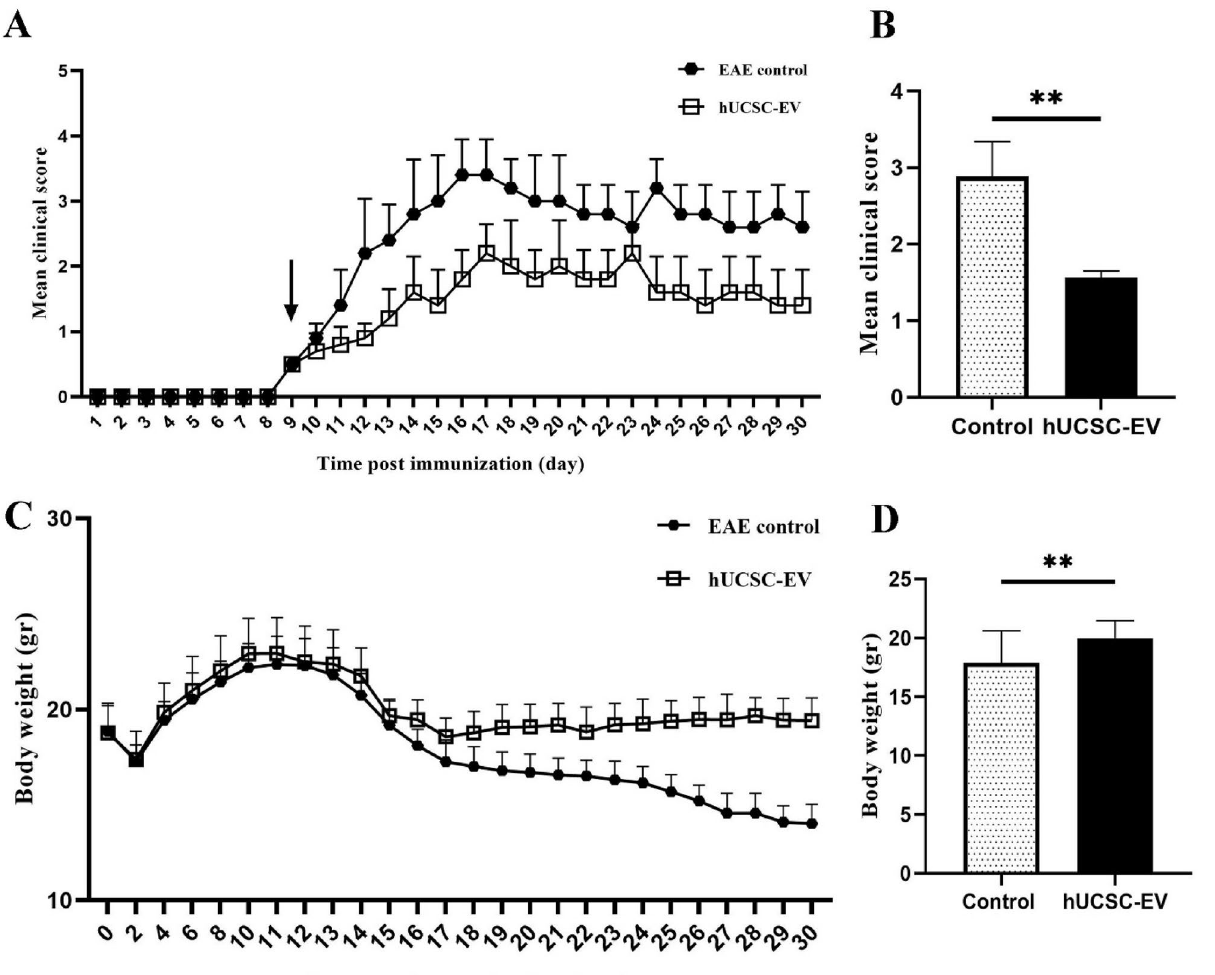
Figure 3. Comparison of the clinical score and body weight between hUCSC-EVs-treated and EAE control mice. MOG 35–55 -immunized C57Bl/6 mice were treated with PBS (EAE control) or hUCSC-EVs on day-9 post immunization (black arrow) ( A ). The MMCS of hUCSC- and MSC-EVs-treated mice were significantly lower than the MMCS of EAE control mice ( B ). The body weight of hUCSC-EVs-treated mice were significantly higher than the body weight of EAE control mice ( C , D ). Data are shown as mean ± SD. **p < 0.01. EAE experimental autoimmune encephalomyelitis, hUCSC-EV human umbilical cord mesenchymal stem cell- extracellular vesicle, MMCS maximum mean clinical score, SD standard deviation.